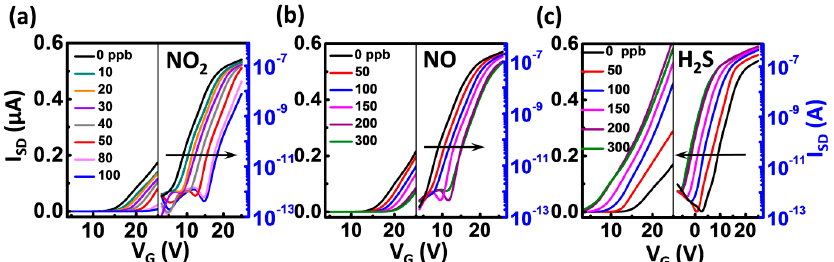
Figure 4. Room-temperature transfer characteristics of the gas-dielectric SnO 2 nanobelt device to various concentrations of NO 2 , NO and H 2 S. ( a , b ) The transfer curves shift monotonically towards the positive direction of gate voltage (V G ) with the increased NO 2 and NO concentrations. ( c ) The transfer curves shift monotonically towards the negative direction with the increased H 2 S concentrations.